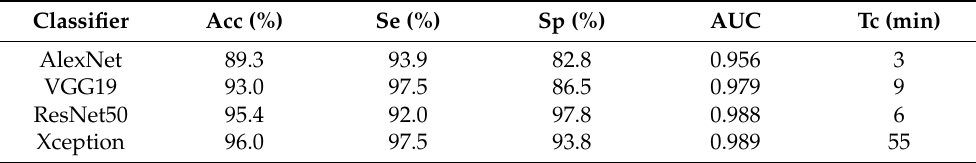
Table 5. Performance of four types of neural networks in the UST-MFCC datasets.